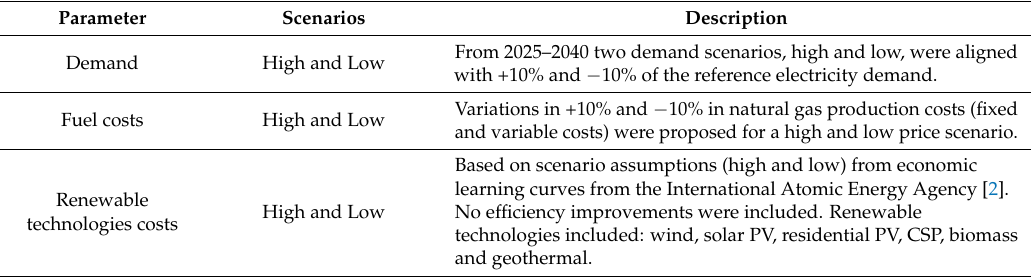
Table 2. Reference and boundary scenarios for the parameter sensitivity